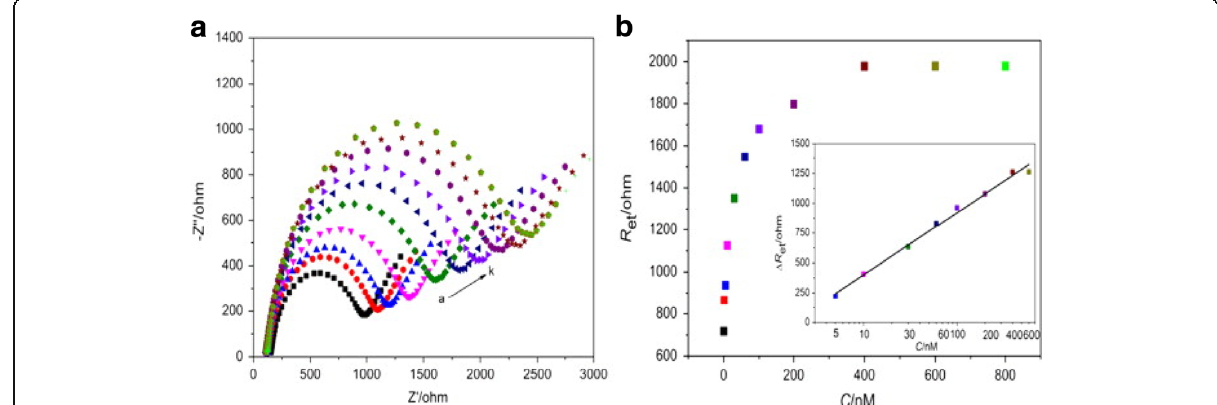
Δ R et with the logarithm of acetamiprid concentrations (reprinted